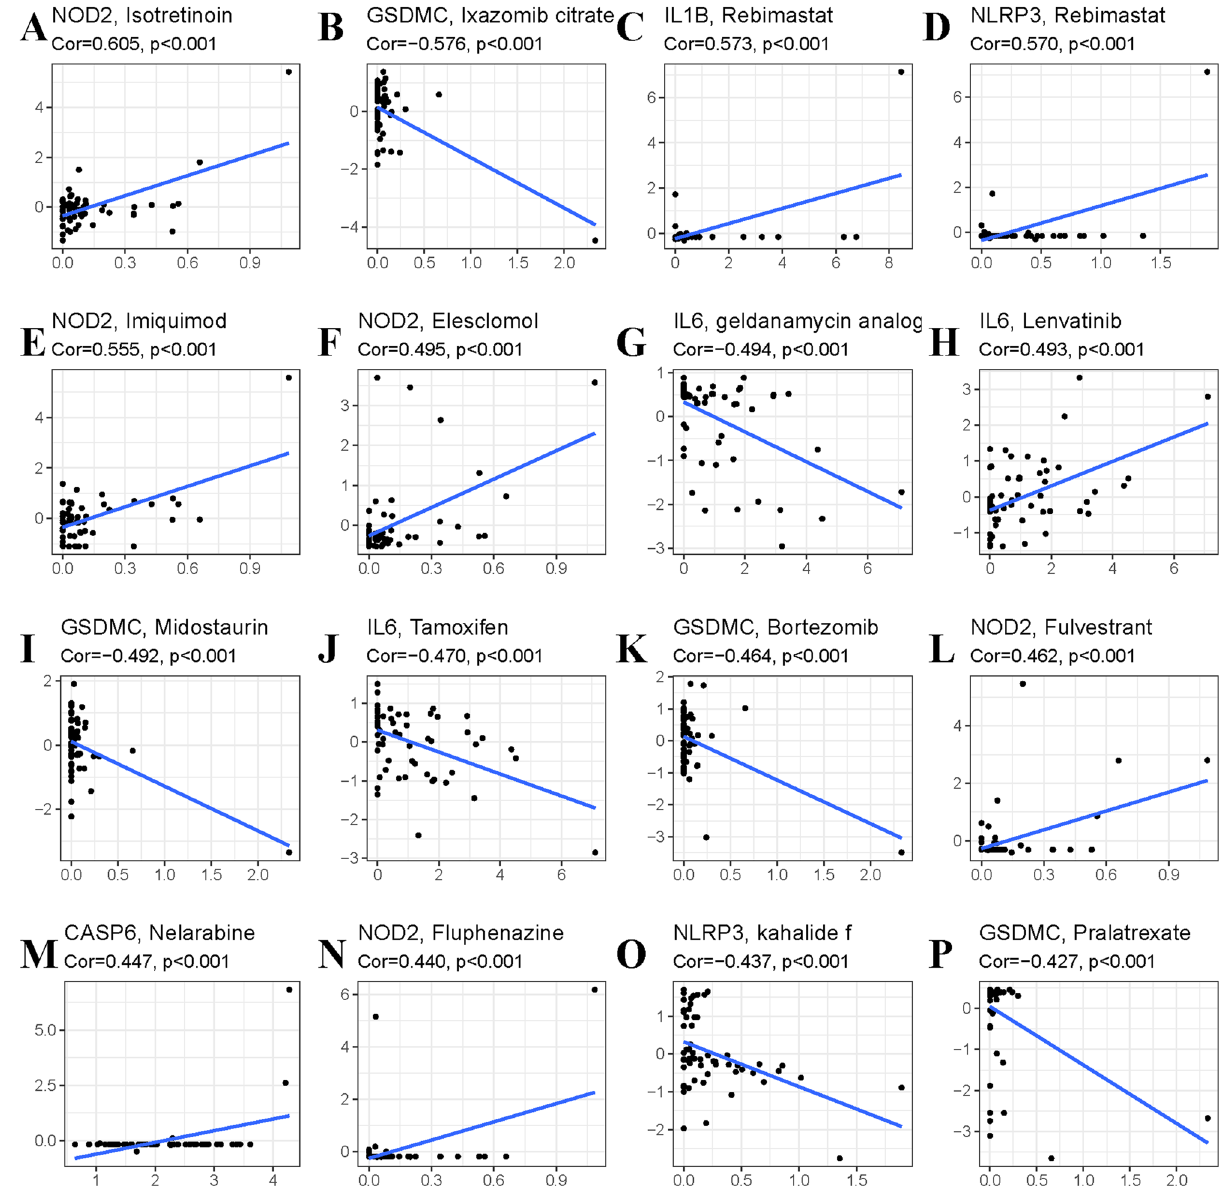
Figure 9. Top 16 potential compounds related with pyroptosis genes. ( A ) NOD2 and isotretinoin. ( B ) GSDMC and Ixazomib. ( C ) IL1B and Rebimastat. ( D ) NLRP3 and Rebimastat. ( E ) NOD2 and Imuiquimod. ( F ) NOD2 and Elesclomol. ( G ) IL6 and Geldanamycin analog. ( H ) IL6 and Lenvatinib. ( I ) GSDMC and Midostaurin. ( J ) IL6 and Tamoxifen. ( K ) GSDMC and Bortezomib. ( L ) NOD2 and Fulvestrant. ( M ) CASP6 and Nelarabine. ( N ) NOD2 and Fulvestrant. ( O ) NLRP3 and Kahalide. ( P ) GSDMC and